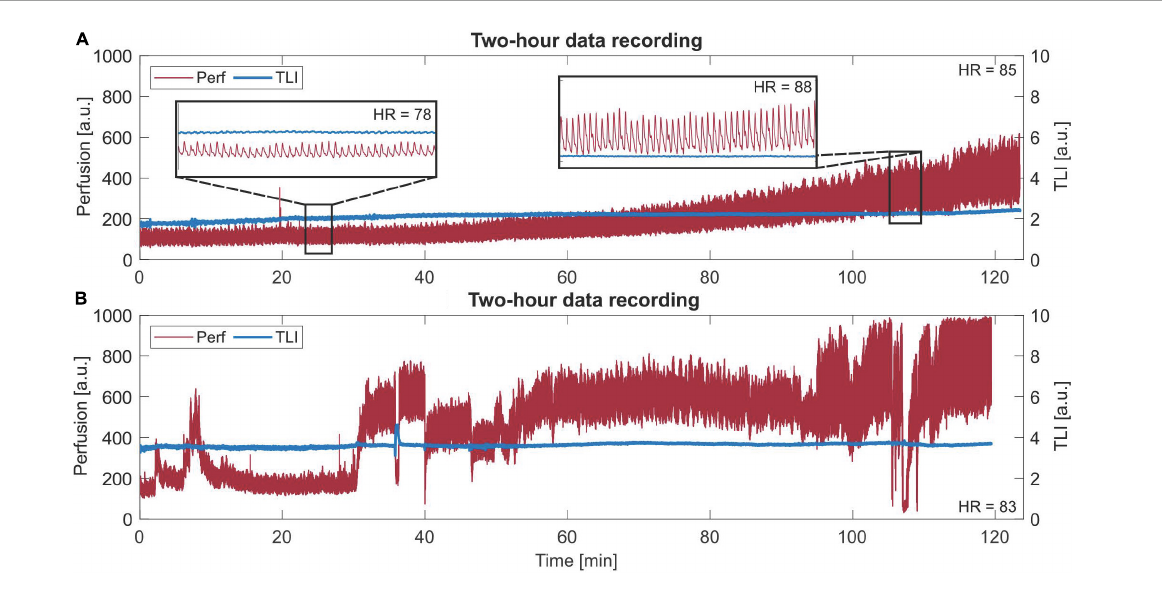
FIGURE9 Long-term (120 min) laser Doppler flowmetry (LDF) data. (A) A slowly increasing trend in the perfusion signal. Two zoom-in areas of 30 s are given, where a different morphology of each beat in the perfusion signal can be seen for each respective area. The given heart rate (HR) is the mean HR of the whole sequence. Observe the difference in HR between the two zoom-ins. (B) Data with more dynamic changes in levels and peak-to-peak